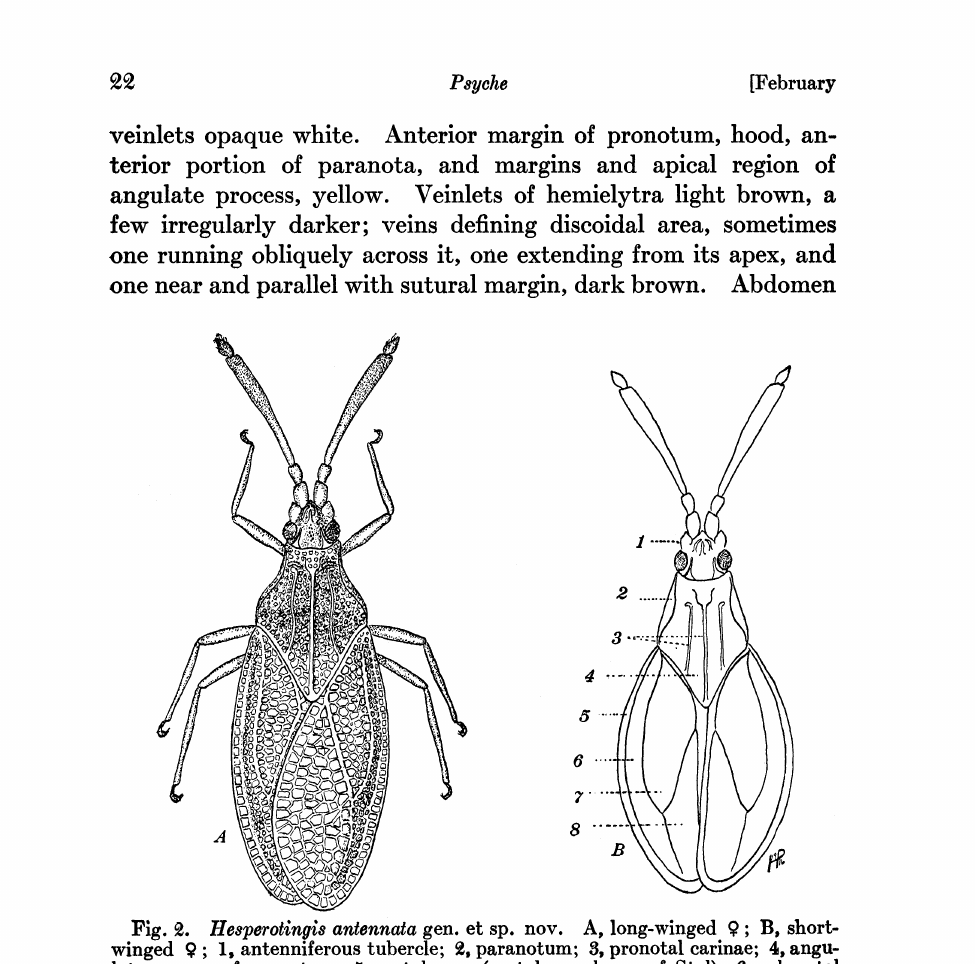
. Hesperotlngls antennata gen. et sp. nov. A, long-winged B, short- winged 9 1, antenniferous tubercle; $, paranotum; 8, pronotal carinae; 4, angu- late process of pronotum; 5, costal area (costal membrane of Stal); 6, subcostal area (costal of Stal); 7, discoidal area; 8, sutural area (apical of Puton in long- winged form). beneath chestnut brown, shining, sutures darker; buccule, sternal ridges, and pleural margins pale. Spines of head somewhat variable in length and shape, the two anterior short, strongly curved, and almost or quite meeting over apex of median; eyes strongly granulated, as seen from above longer than wide; antenniferous tubercles as seen from above prominent, convex exteriorly, acute at apex, obliquely truncate. Antennae almost as long as head and pronotum together;